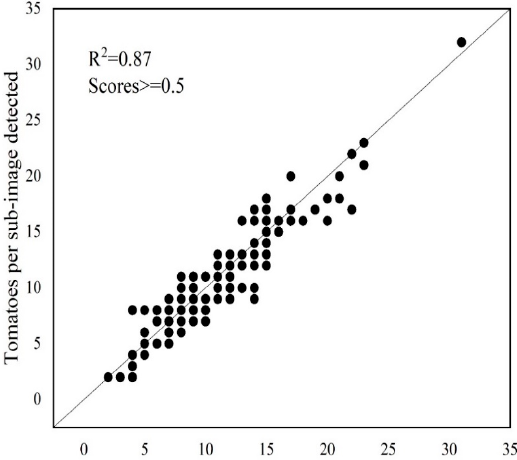
Figure 7. Correlation between labelled and detected tomatoes per subimage in the test